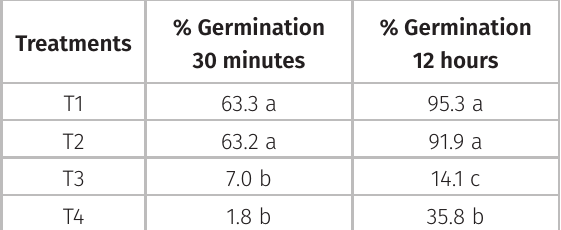
Table VI. Germination of pollen grains of H. undatus (white-fleshed pitaya) evaluated 30 minutes and 12 hours after inoculation in culture medium. T1 = 7 p.m., without cup cover; T2 = 7 p.m., with cup cover; T3 = 7 a.m., without cup cover; and T4 = 7 a.m., with cup cover. % Germination % Germination Treatments 30 minutes